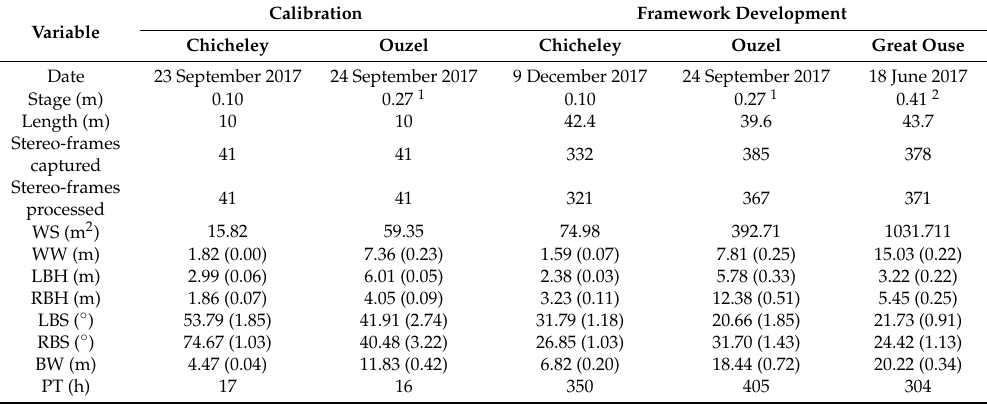
Table 2. Summary of variables describing the field work conditions, the study sites and the number of frames captured at each site. All the hydromorphological measures, except Water Surface Area (WS), were derived from the Total Laser Scanner (TLS) point cloud based on 10 cm and 50 cm interval cross sections for the calibration and framework development sites, respectively. The hydromorphological measures (Table 1) reported are: wetted water width (WW), left bank height (LBH), right bank height (RBH), left bank slope (LBS), right bank slope (RBS) and bankfull width (BW). “Stage” stands for the river stage and “Length” for the reach length. Values in brackets denote the standard errors. The number of stereo-frames reported for each of the 10 m reaches represent the images captured and processed for each of the stereo-camera height settings considered. PT stands for computer processing time based on an Intel Xeon E5-1650v3 3.50 GHz processor, 32 GB RAM, and GeForce GTX 1080 (NVIDIA, Santa Clara, CA, USA) graphics card. 1 [25], 2